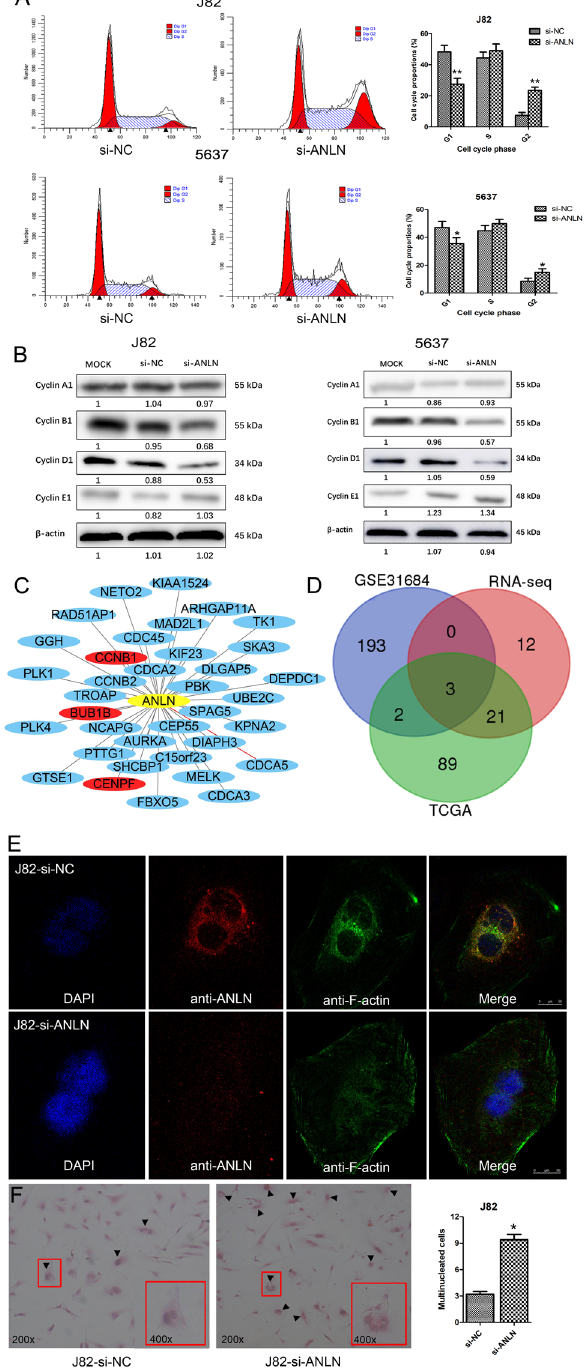
Figure 5. Cell cycle progression and binucleation process were impaired after ANLN knockdown. ( A ) Knockdown of ANLN induced G2/M phase arrest in J82 and 5637 cells. ( B ) Western-blot analysis of cell cycle checkpoint proteins in J82 and 5637 cells with different treatments (MOCK, si-NC, si-ANLN). ( C ) Network of ANLN co-expressed genes from present RNA-seq data, the distance between ANLN and gene nodes was negatively correlated with Pearson score (red gene nodes represented genes co-expressed with ANLN in RNA-seq, TCGA and NCBI-GEO datasets). ( D ) The Venn diagram of differentially expressed genes in three datasets. ( E ) Confocal images of ANLN and F-actin distribution after transfection of J82 cells with si-ANLN or control RNA. ( F ) Hematoxylin & eosin staining showed that the percentage of multinucleated cells significantly increased after knockdown of ANLN in J82 cells. * p < 0.05; ** p <